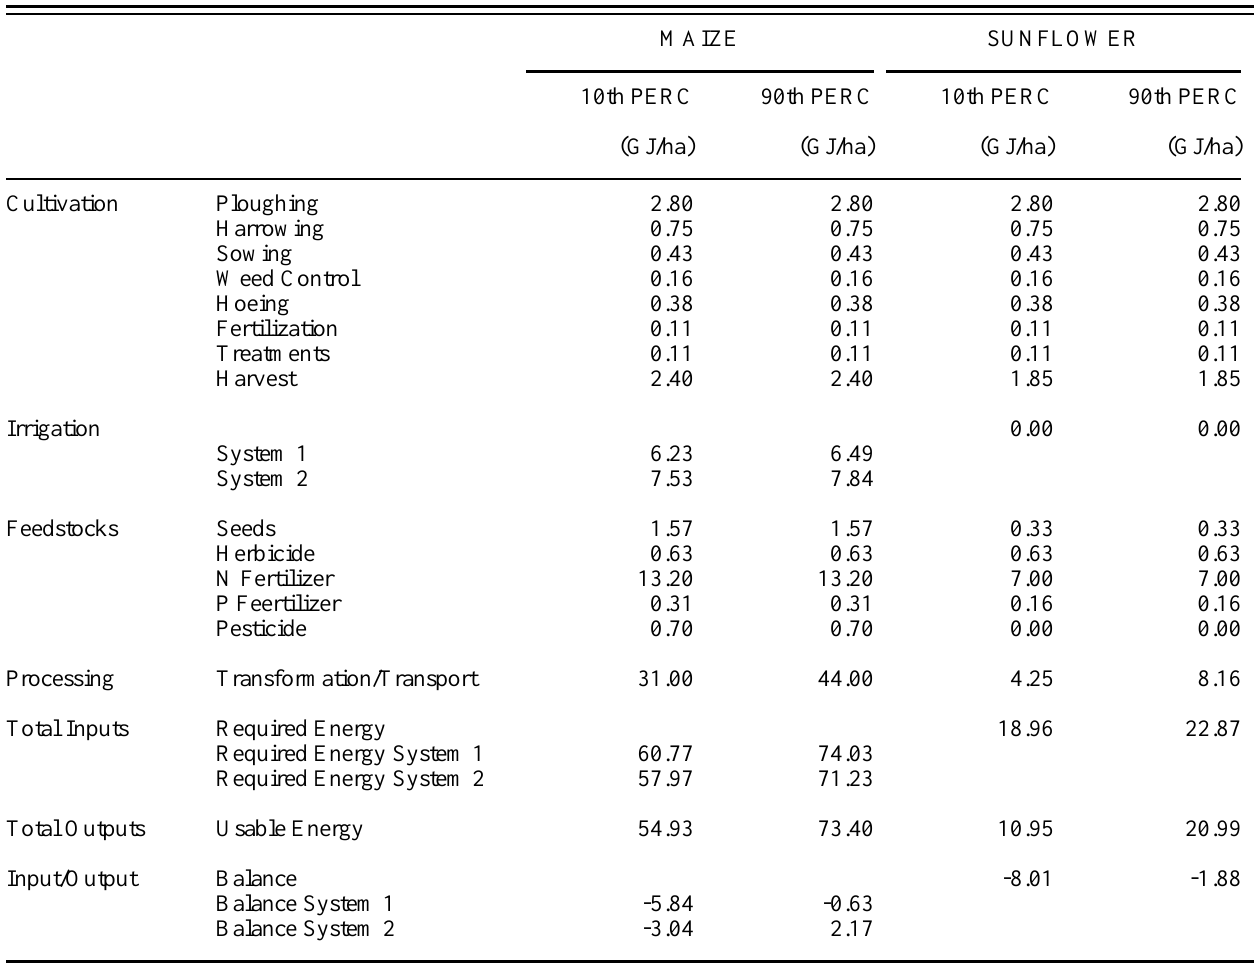
Table 5. Energy balances (GJ/ha) calculated for the production of bioethanol from maize biomass and for the production of pure vegetable oil from sunflower biomass. Legend: PERC =